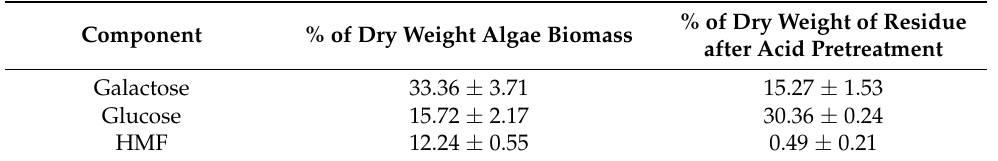
Table 1. Monosaccharide composition of K. alvarezii used in this project. Component